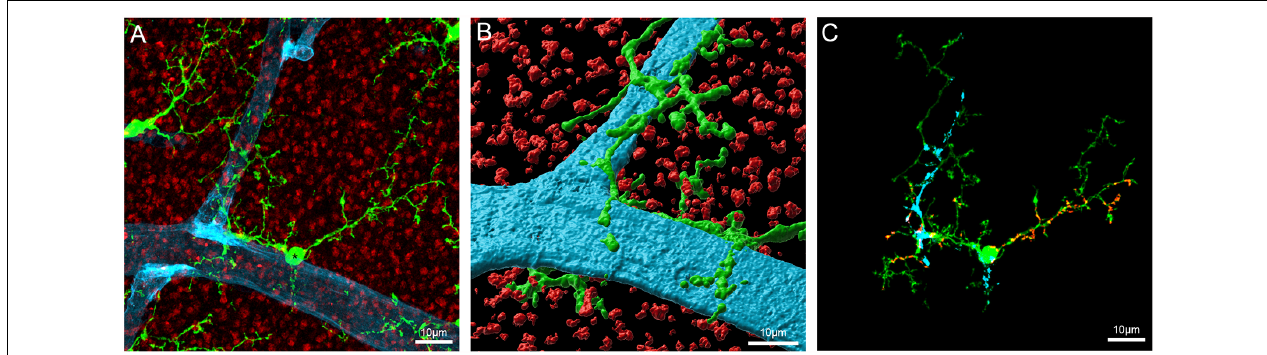
FIGURE 4 | Microglia contact components of the retinal vasculature. (A) Flatmount of the Cx3CR1 +/GFP mouse retina imaged at the level of the outer plexiform layer labeled for the presynaptic terminal marker, VGLUT1 (red), and the blood vessel marker, IB4 (blue). GFP labeled microglia are visible as green cells abutting the blood vessels. (B) Imaris rendered microglia abutting the blood vessel in panel (A) . (C) Image showing areas of contact between blood vessels, synapses and the indicated (*) microglia in panel (A) . Putative contacts between microglia and blood vessels or synapses were defined by the apparent colocalization of fluorescence. The blue shading indicates areas of contact between the microglia and blood vessel, the red shows areas of contact between microglia and synapses.